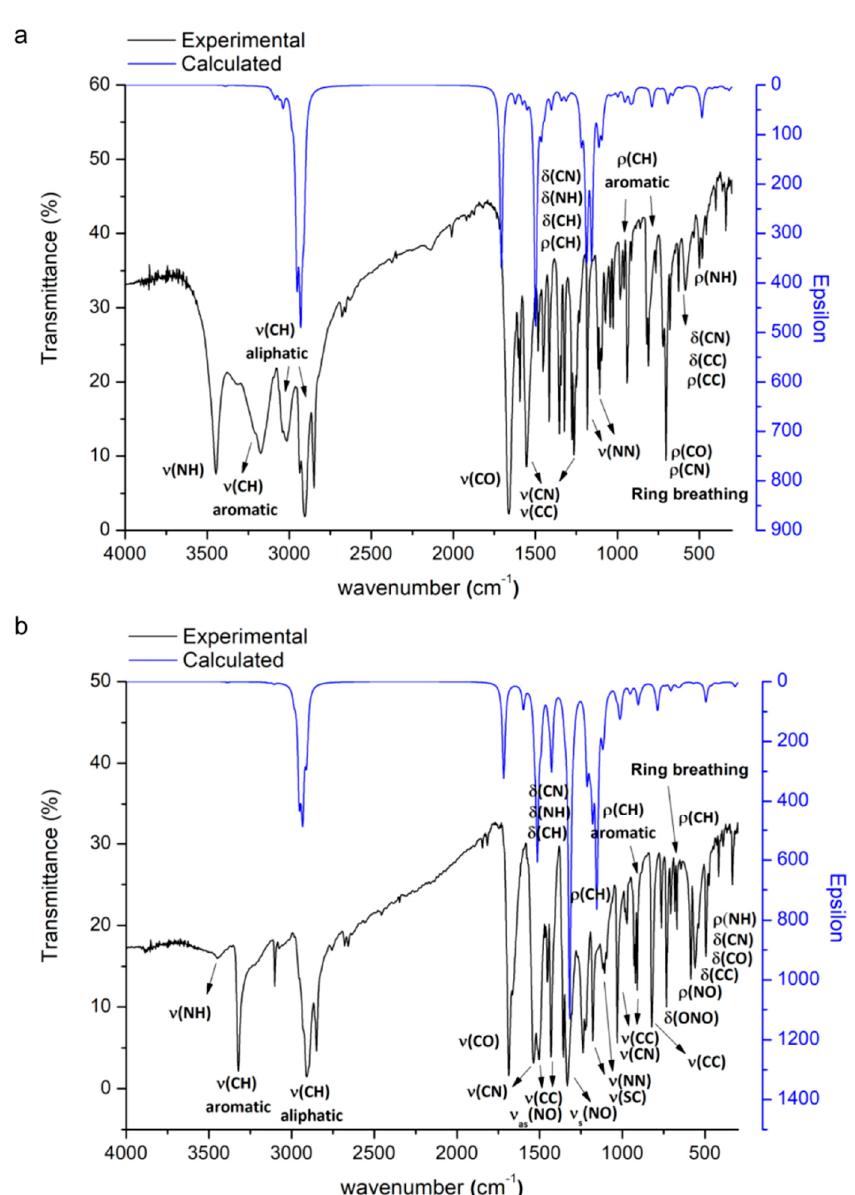
Figure 6. Experimental and calculated IR spectra of compounds 1 ( a ) and 2 ( b ). Theoretical spectra were determined from the gas-phase optimized geometries at the B3LYP/6-31+G(d,p) level. The assignment of the most important IR bands are depicted.